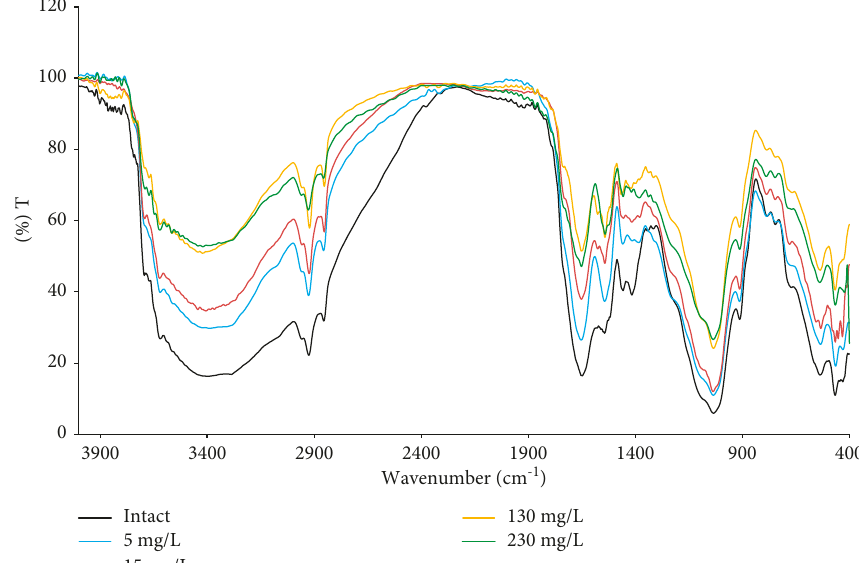
Figure 6: The comparison between the FTIR spectra of intact biofilm and the copper(II)-bound biofilms. The concentrations (mg/L) were the initial concentration of the CuSO 4 solutions used in the adsorption isotherm